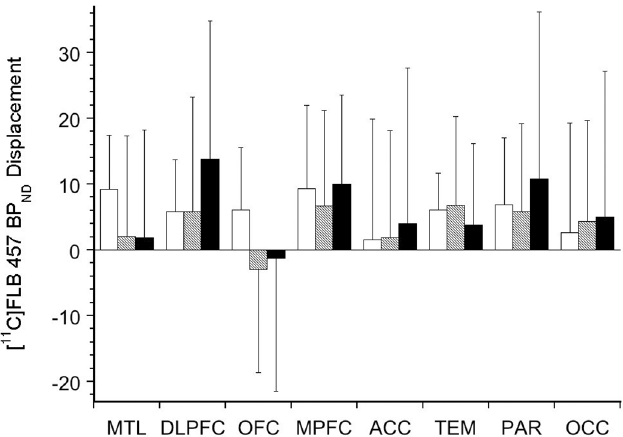
Fig 3. Amphetamine-Induced Δ [ 11 C]FLB457 BP ND in Genotyped Healthy Subjects. The bar graph shows the amphetamine-induced reduction of [ 11 C]FLB 457 BP ND in cortical regions of interest comparing Val/Val (white bars), Val/Met (shaded bars), and Met/Met (black bars) genotyped healthy subjects.